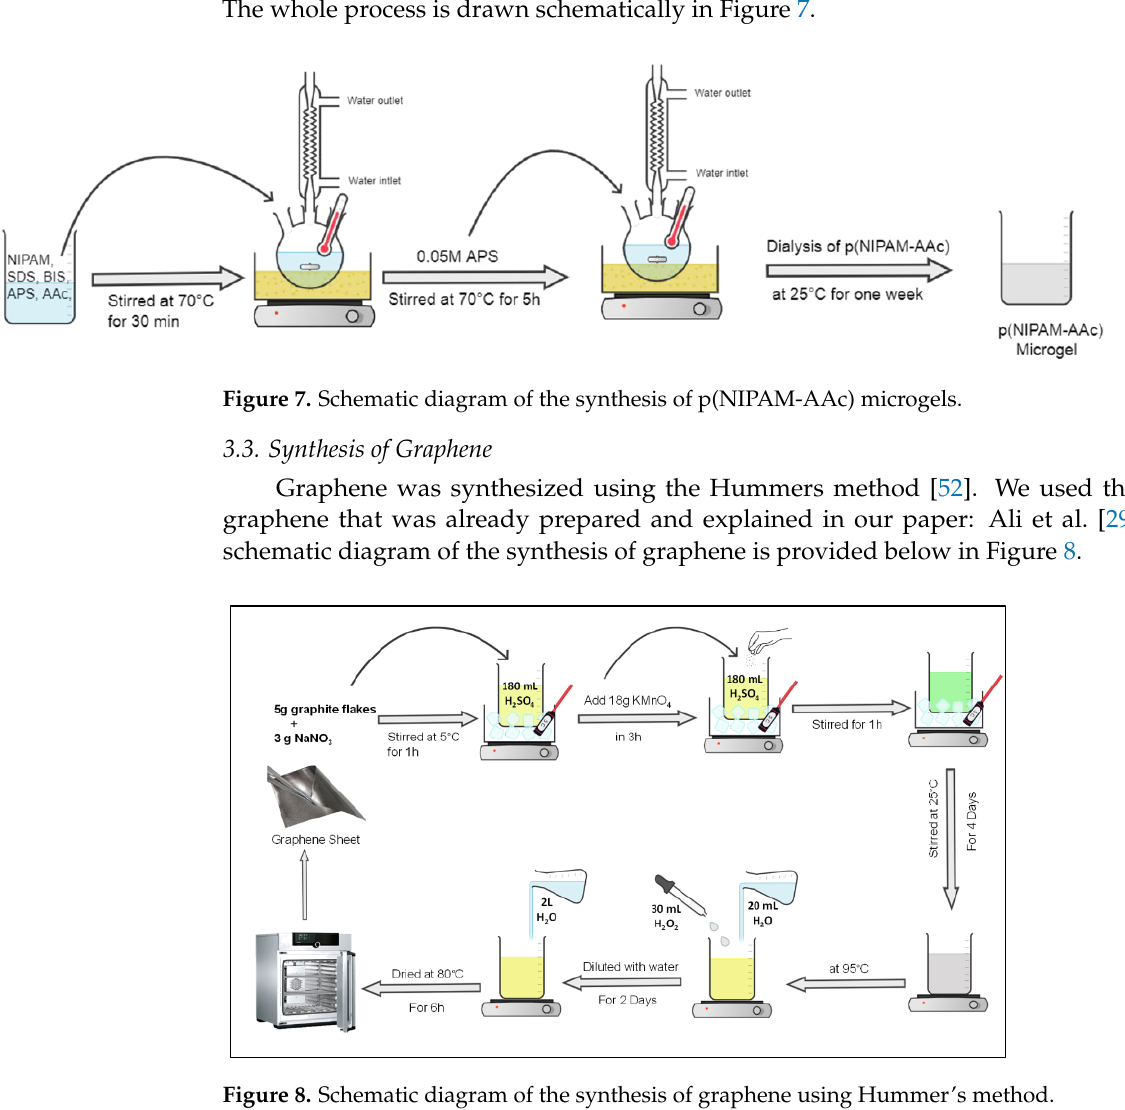
Figure 8. Schematic diagram of the synthesis of graphene using Hummer’s method.